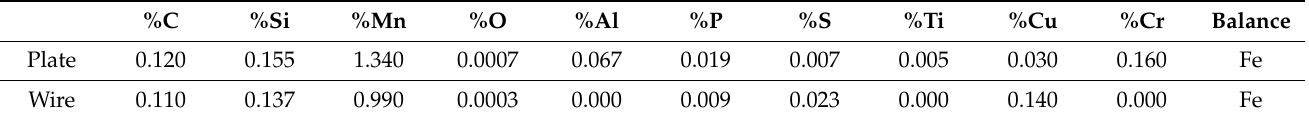
Table 1. Base plate and weld wire compositions (mass%).